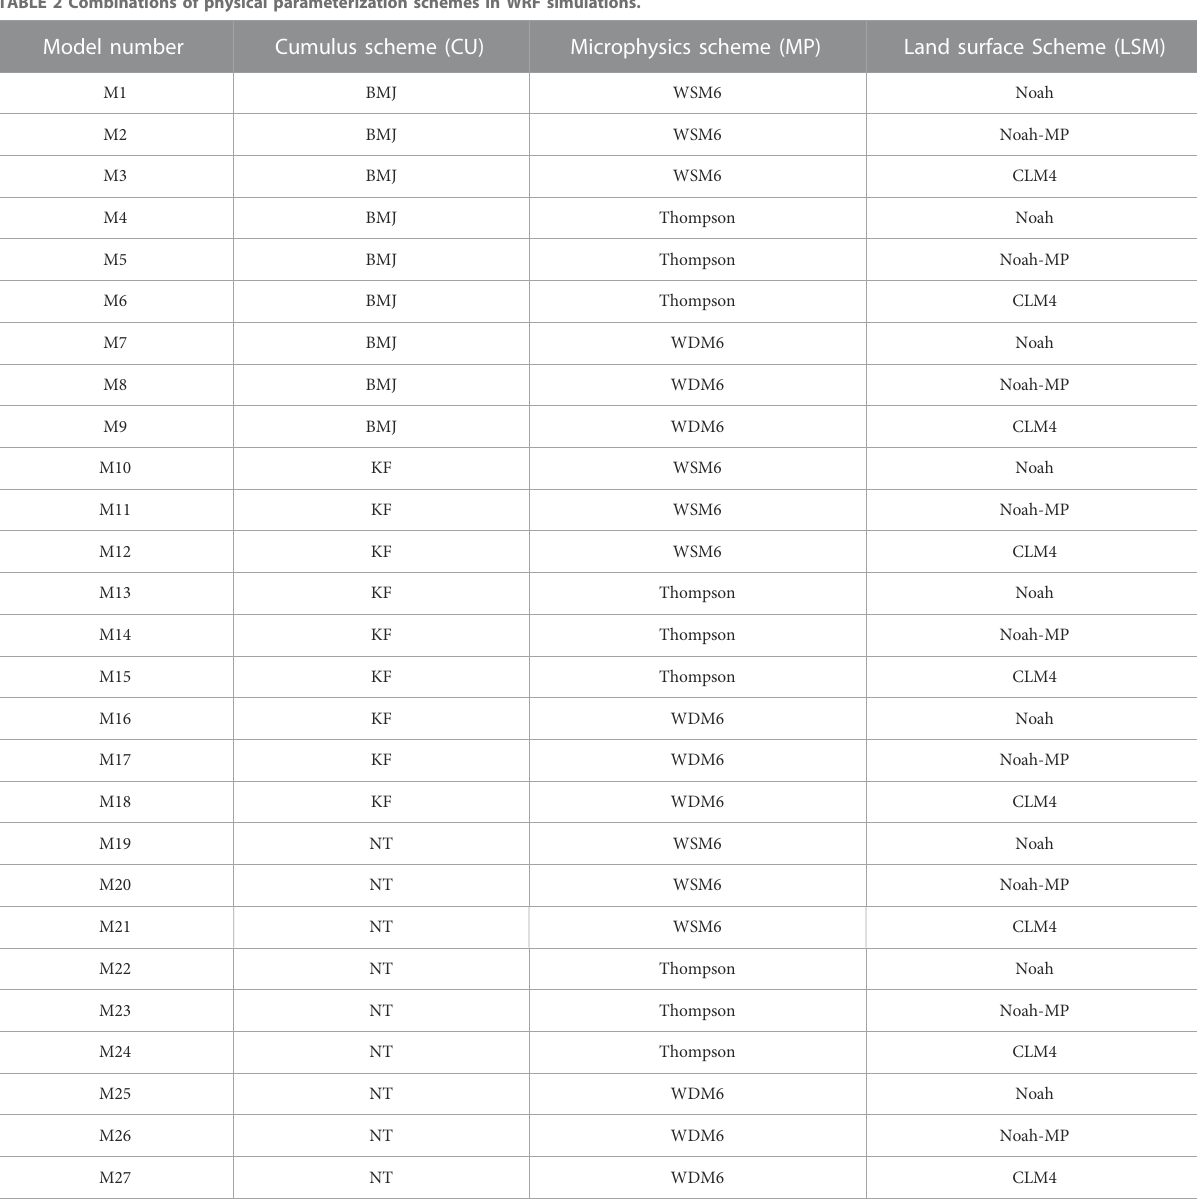
TABLE 2 Combinations of physical parameterization schemes in WRF